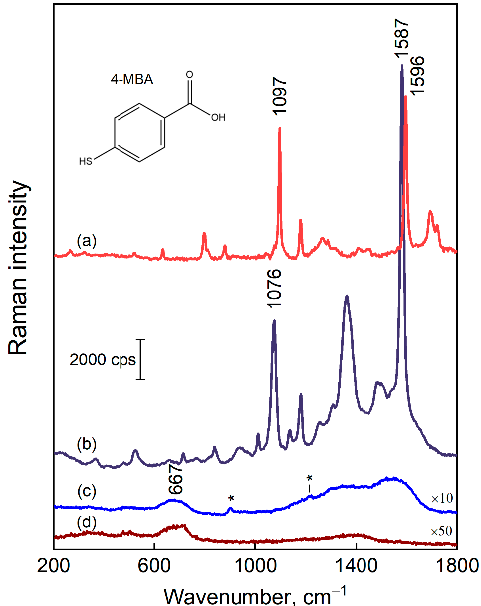
Figure 6. Raman-difference spectrum of 0.1 M 4-MBA in ethanol solution (ethanol spectrum is subtracted) ( a ), SERS spectrum of 4-MBA adsorbed on Fe 3 O 4 @AgNP_0.5 ( b ), SERS spectrum of bare Fe 3 O 4 @AgNP_0.5 ( c ). Notice the asterisks that mark spectral features due to contaminations. Raman spectrum of magnetite nanoparticles ( d ). The laser excitation wavelength was 532 nm. The scale bar applies for the ( b – d ) (notice the multipliers), whereas the intensity of ( a ) is arbitrary.